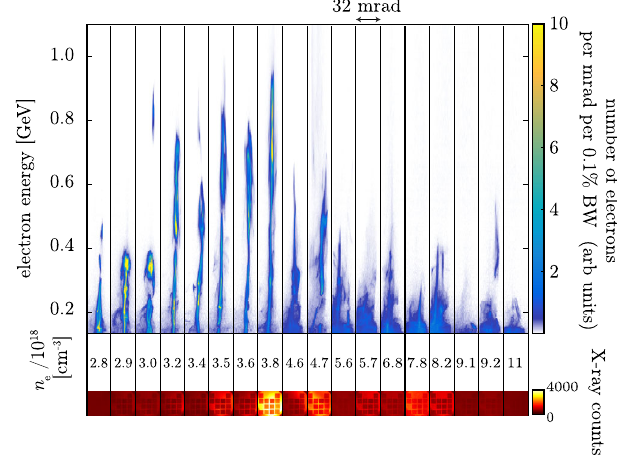
FIG. 2. Variation of electron and x-ray beams as a function of n for the 10 mm nozzle. Top: Dispersion-corrected spectrally e dispersed images of the electron beam for a selection of shots. The horizontal axis represents the angle at which electrons exit the accelerator in the nondispersion plane. Bottom: X-ray CCD camera images for the same